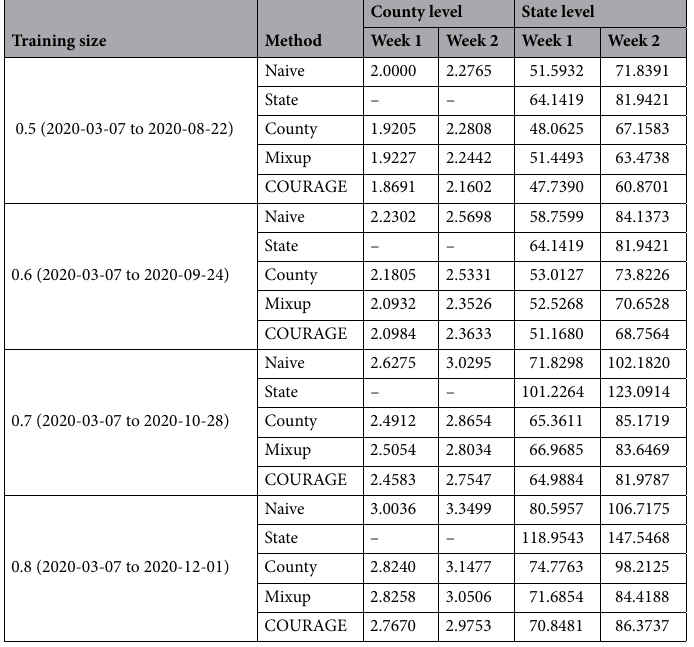
Table 1. Prediction of county-level and state-level weekly total number of deaths. The comparison metrics used is MAE, and the testing dataset starts from the 2020-08-23, 2020-09-25, 2020-10-29 and 2020-12-02 to 2021-02-07 for each corresponding training dataset.